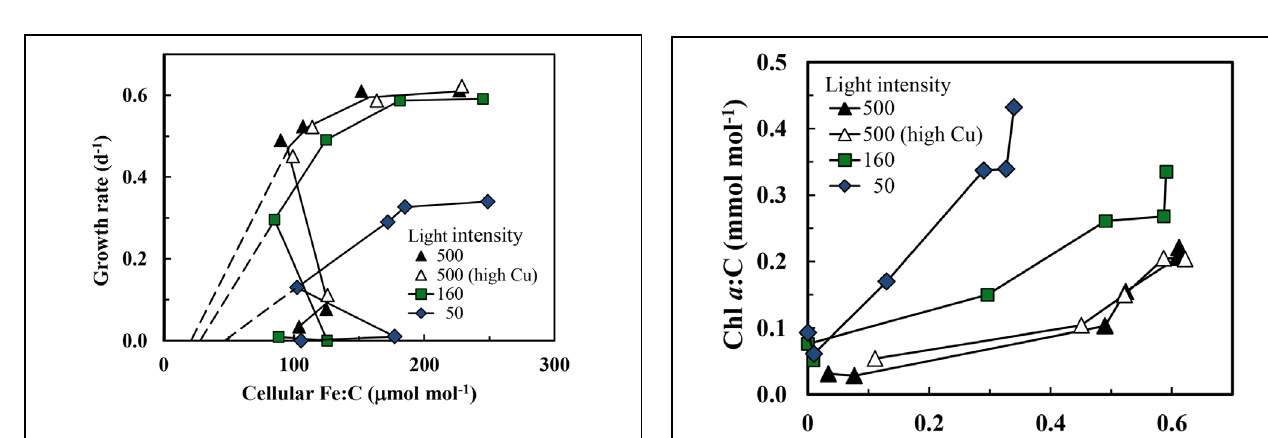
FIGURE 2 | The iron-limited growth rate normalized to the maximum iron sufficient rate ( µ / µ max ) in S. bacillaris plotted as a function of Fe (cid:2) concentration . The treatments and symbols are defined in brief on the figure and in detail in the legend of Figure 1 . The low copper data (all but the open triangles) were previously published in Sunda and Huntsman (1997).